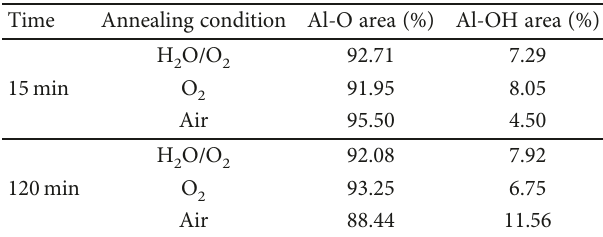
Table 1: The ratio of each bonding peak for each annealing